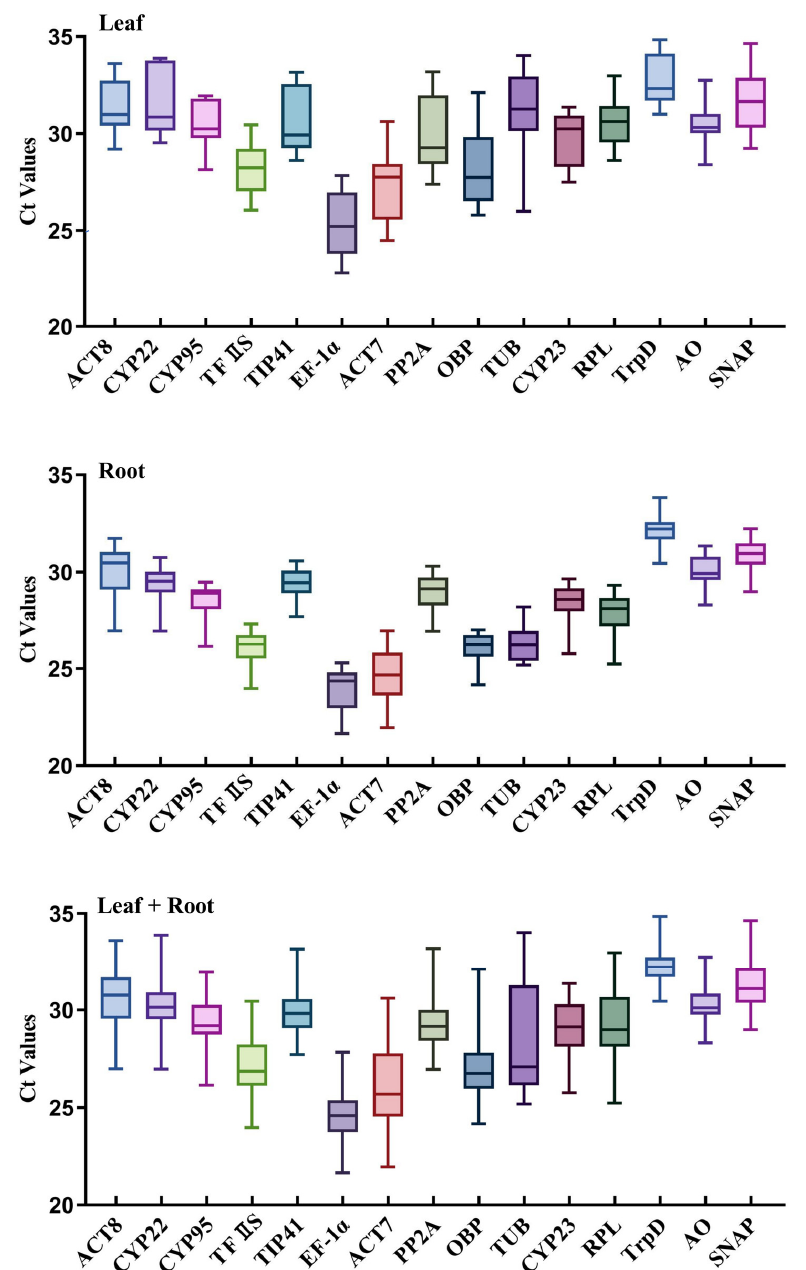
Figure 3. Gene expression levels of the candidate reference genes displayed as Ct values across leaf, root, and leaf + root samples of L. rotata from five habitats. The graph also shows the variation in Ct values for each reference gene. Whiskers across the box depict the highest and lowest values.